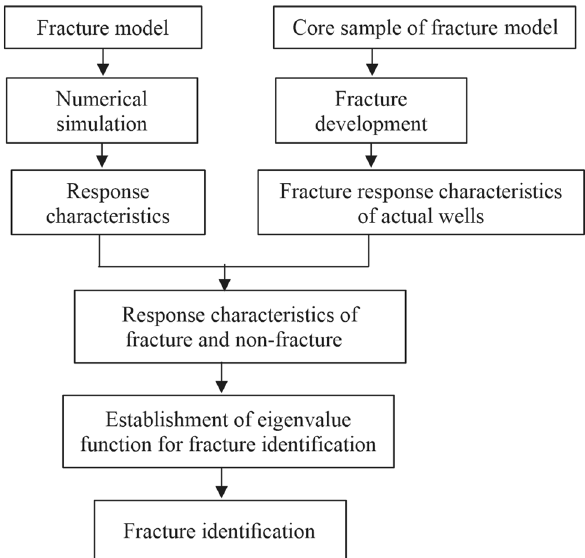
Figure 3. General methodology and technical routes of the